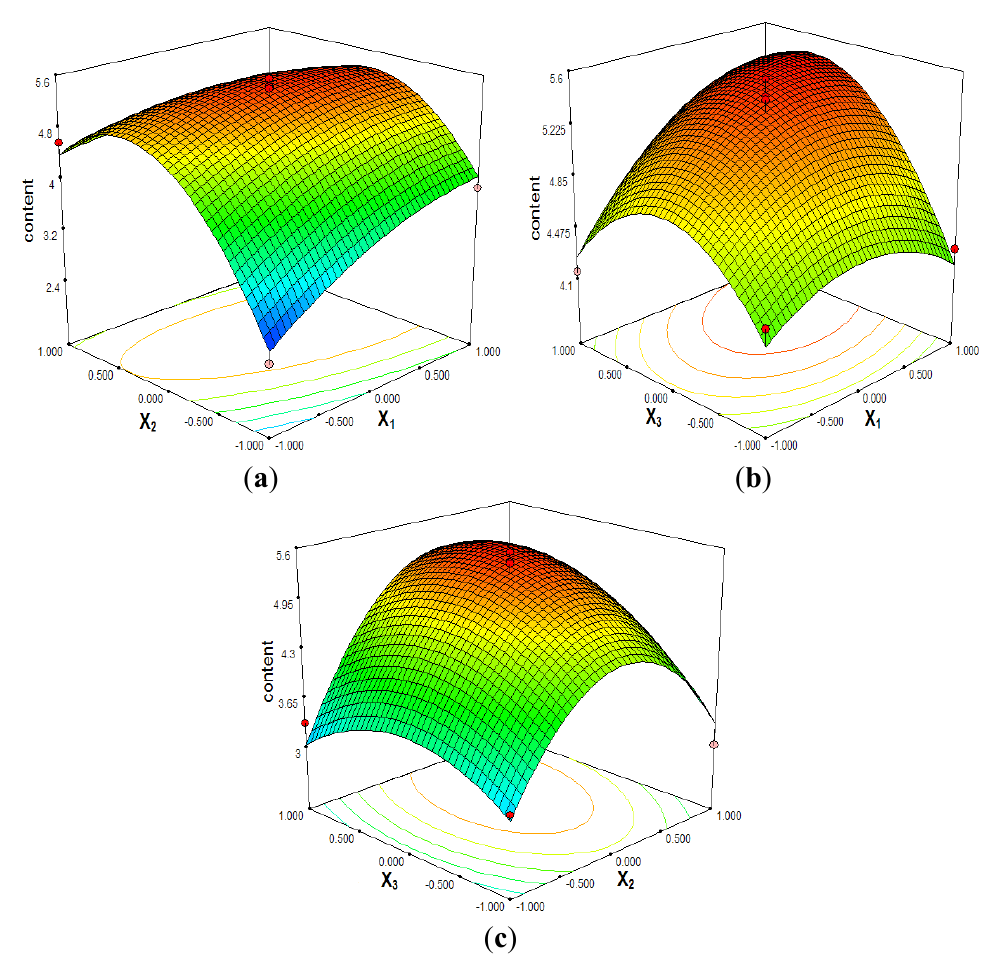
Figure 2. Response surface plots (3D) of reaction time, reaction temperature and ratio